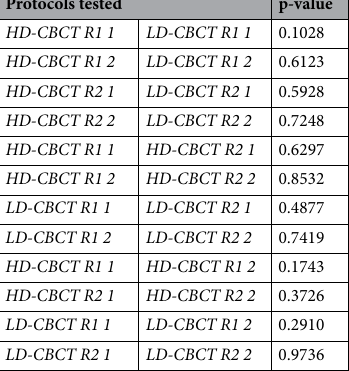
Table 2. Differences in mean f values. No significant differences in mean f values were observed between HD-CBCT and LD-CBCT according to the paired t-test (p < 0.05).